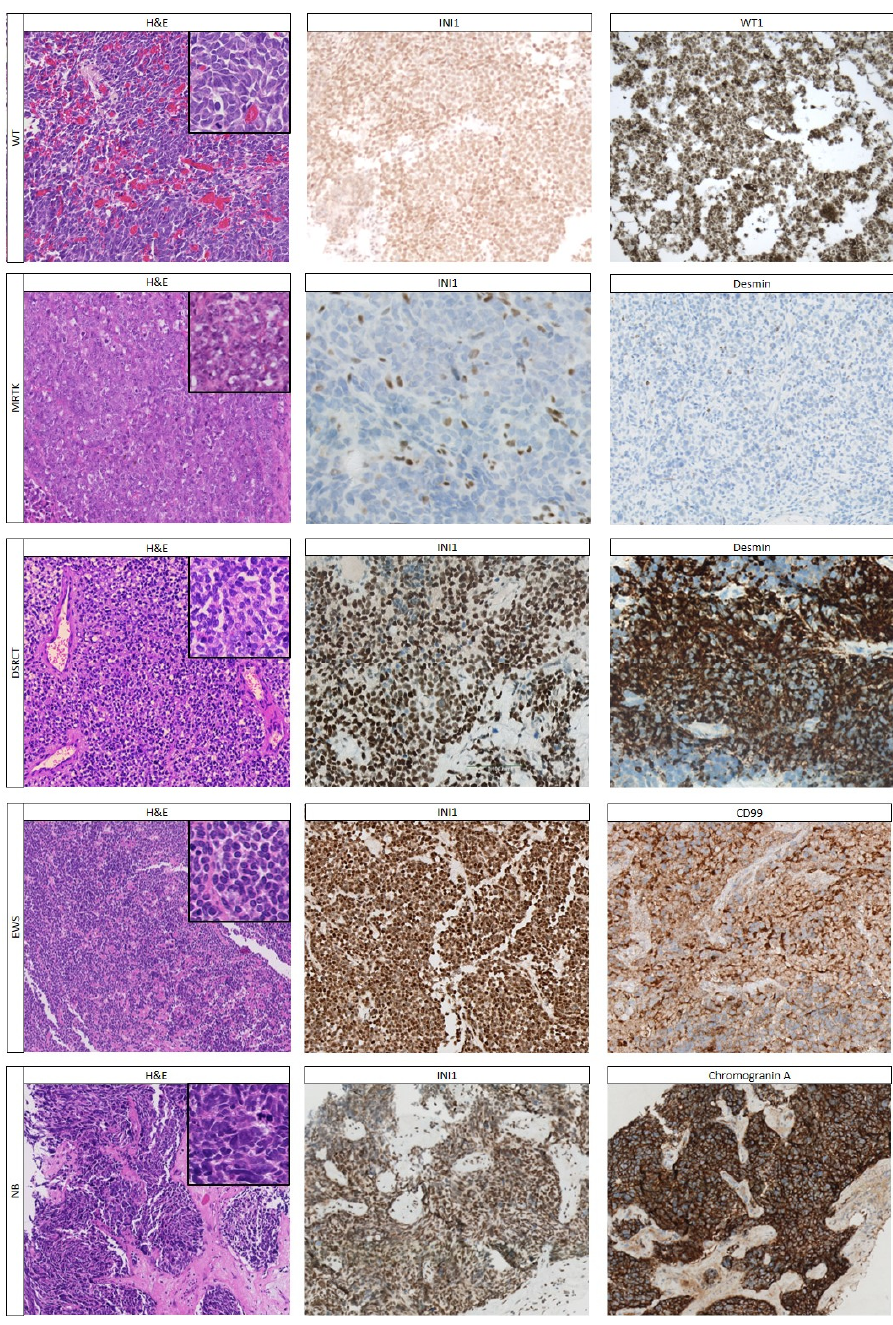
Figure 3. The most common pediatric tumors with an undi ff erentiated pattern and their most important immunohistochemical stainings. Wilms tumor (WT) with undi ff erentiated blastema shows strong nuclear staining for INI1 as well as for WT1. Malignant rhabdoid tumors of the kidney (MRTKs) often show large cells with large eccentric nuclei, characteristic loss of INI1 staining and a significant percentage of MRTKs do not stain (or only focally) for muscle markers such as desmin. The rare desmoplastic small round cell tumor (DSRCT), depicted in the third row, highly resembles blastemal WTs specifically with staining for WT1 (only C-terminal clone; not shown) and MRTKs, but with strong staining for INI1 and desmin in all cells. Ewing sarcoma shows INI1 staining and strong membranous CD99. When tumors are large and infiltrate the kidney, tumors such as neuroblastoma (NB) enter the di ff erential diagnosis. As depicted in the last row, these also show a small blue round cell phenotype, without loss of INI1, but with strong staining for neuroendocrine markers such as chromogranin A. H&E and immunohistochemical stainings at 10 × magnification; inset at 40 ×